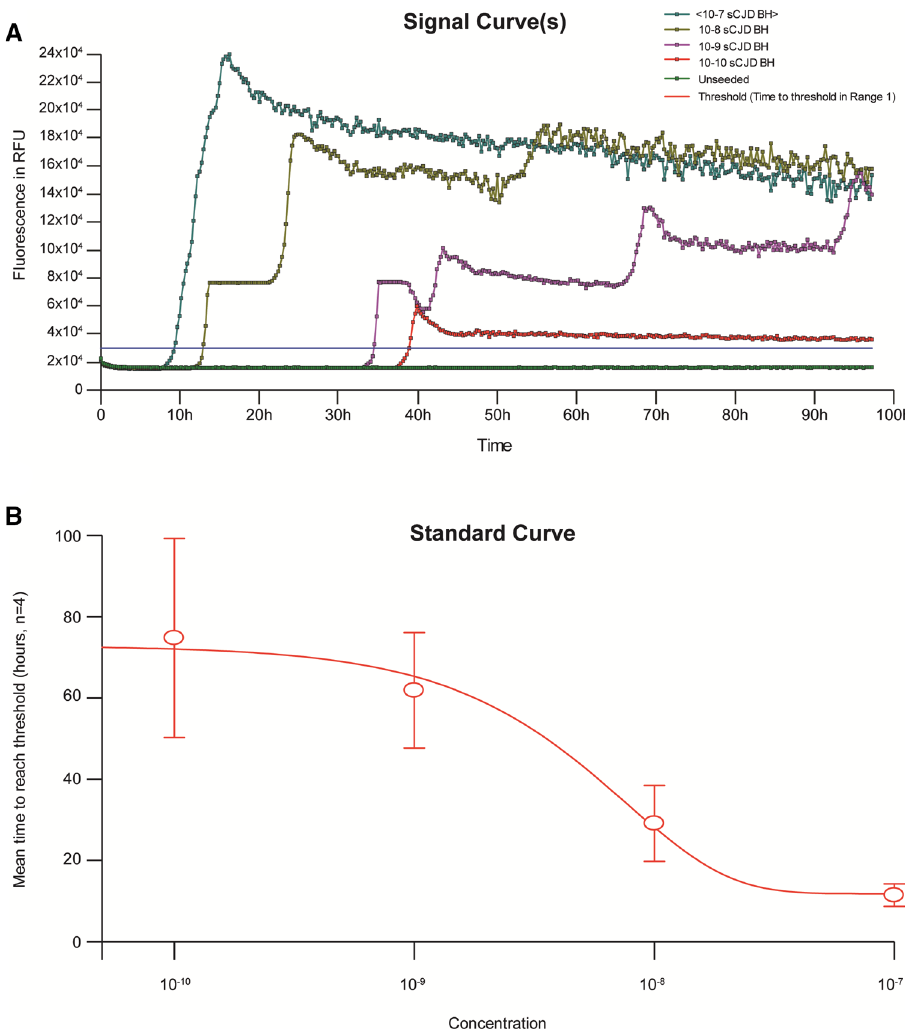
Figure 4. Estimation of CSF prion seeding doses. RT-QuIC reactions seeded by serial dilutions of sCJD 129MM brain homogenates at 50 °C ; each curve representing the average rfu readings across replicate wells ( A ), and dose response curve for estimation of prion seeding doses based on time to threshold lag phases ( B ). Estimation of CSF prion seeding doses were derived from the standard calibration curve ( B ) constructed from the lag phases (time to threshold rfu) of RT-QuIC reactions with BV rPrP seeded by serial dilutions of sCJD BH in ( A ). Data points in ( B ) represent the mean of 4 wells with standard errors of the